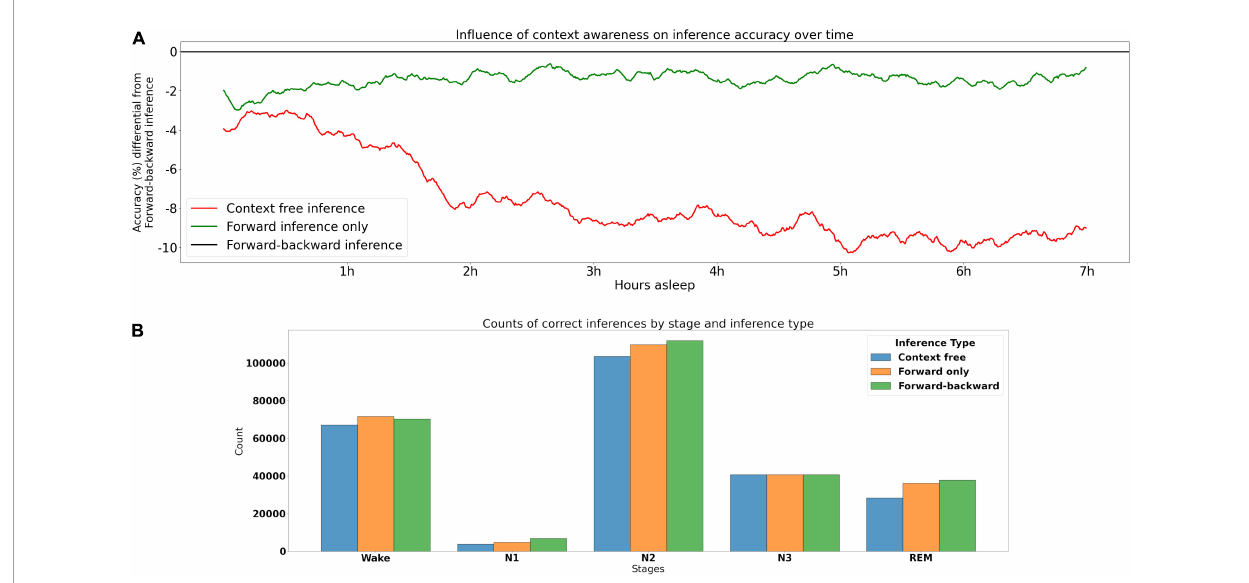
FIGURE2 Contribution of contextual information to accuracy. (A) Accuracy of types of inference over time. The model performs optimally when making use of both preceding and subsequent epochs (forward-backward inference)–this optimal performance is the baseline at 0. The red and green lines indicate the loss in accuracy for context free inference and forward inference (preceding context only), respectively, across time for 355 PSGs in the testing set. (B) Accuracy of sleep stages under different types of inference, higher bars indicate more accurate.